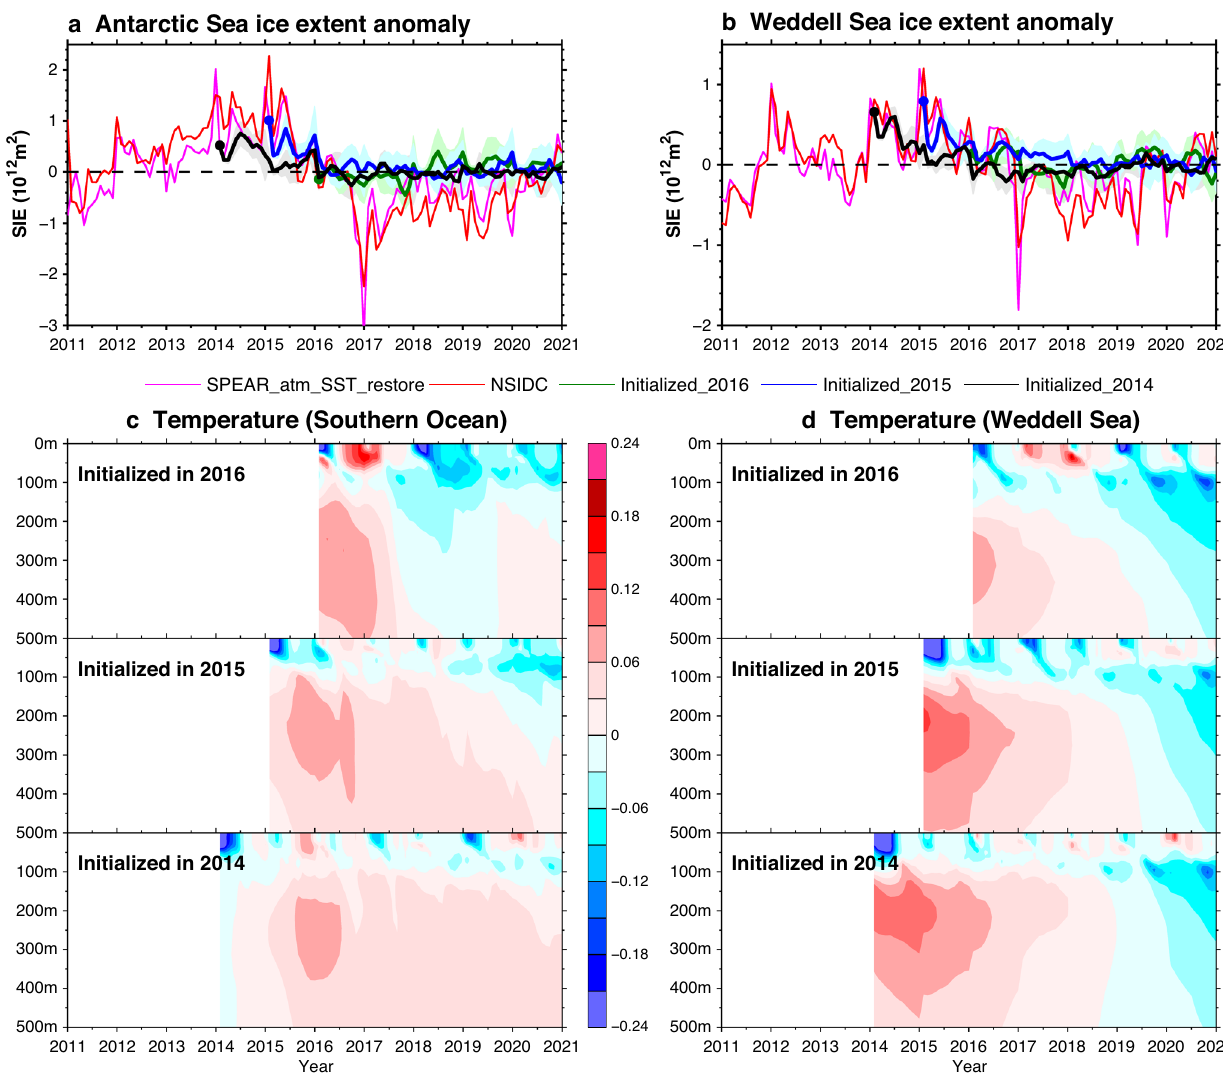
Fig. 4 Decadal hindcasts of Sea ice extent (SIE) and subsurface ocean temperature. a Decadal hindcasts of the total Antarctic SIE initialized in 2014 (black), 2015 (blue), and 2016 (green) along with the SIE time series in SPEAR_atm_sst_restore (magenta line) and National Snow and Ice Data Center (NSIDC) (red line). Lines in the decadal hindcast denote the ensemble mean result, while the shadings denote the ensemble spread represented by the one standard deviation. c Decadal hindcasts of ensemble mean Southern Ocean (60°S – 70°S, 0°E – 360°E) area averaged subsurface temperature evolutions initialized in 2016, 2015, and 2014. b and d are the same as ( a ) and ( c ) but for the Weddell Sea (55°S – 74°S, 50°W – 10°E). Units for the SIE and ocean temperature are 10 12 m 2 , °C,